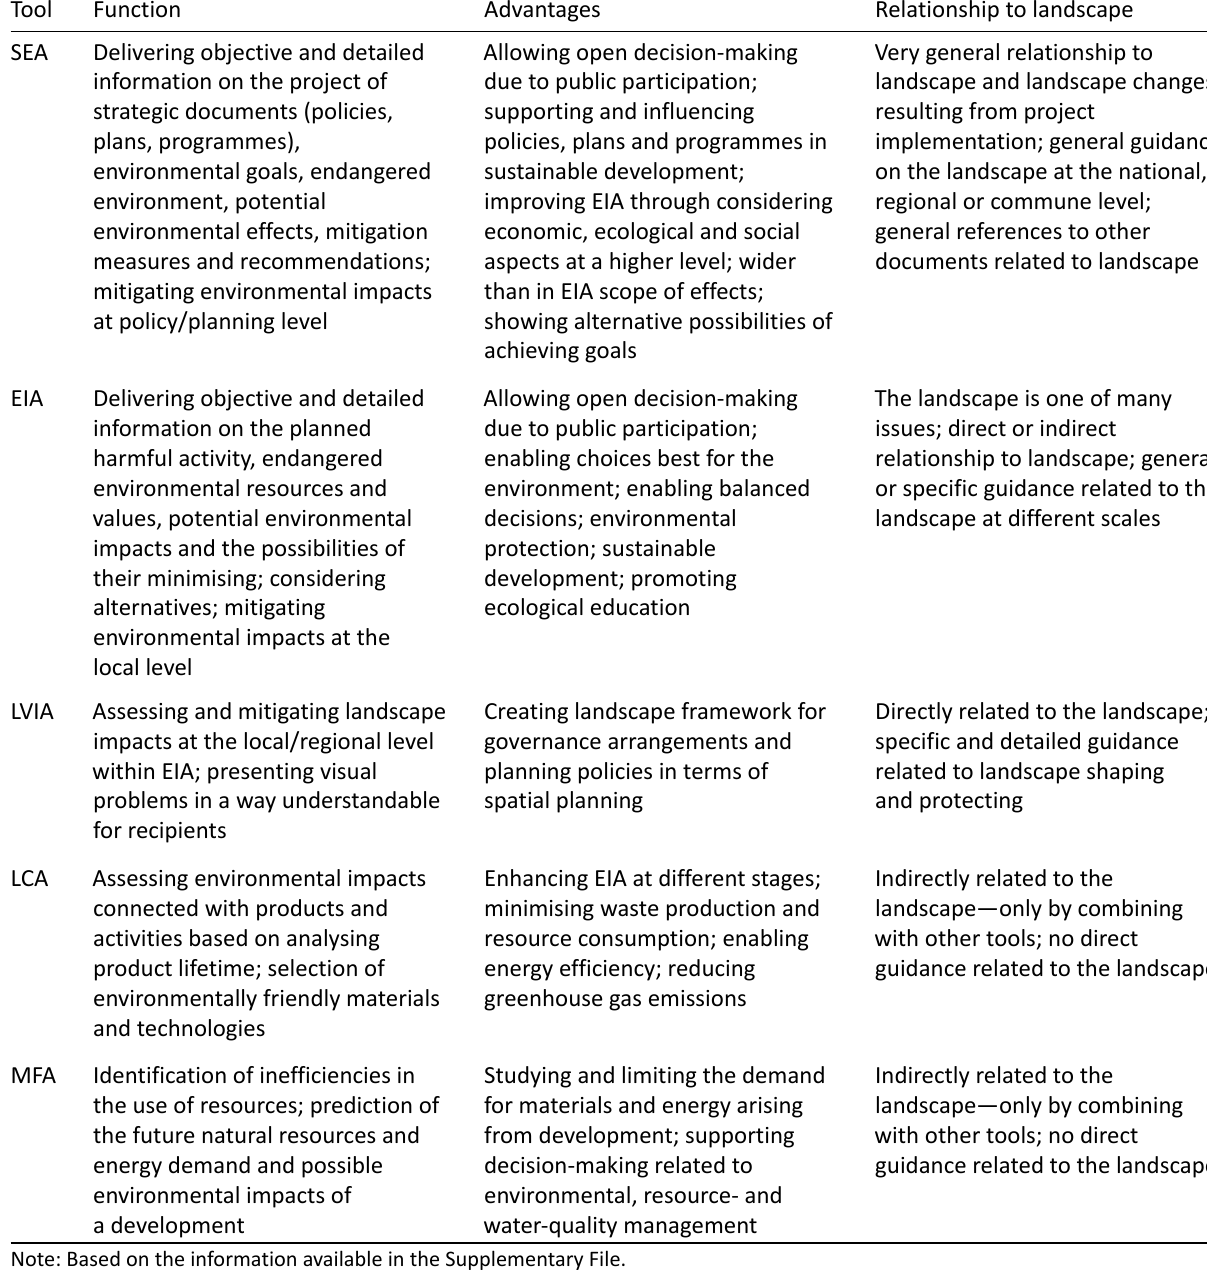
Table 1. Tools reducing environmental and climate changes and their functions, advantages, and relationship to